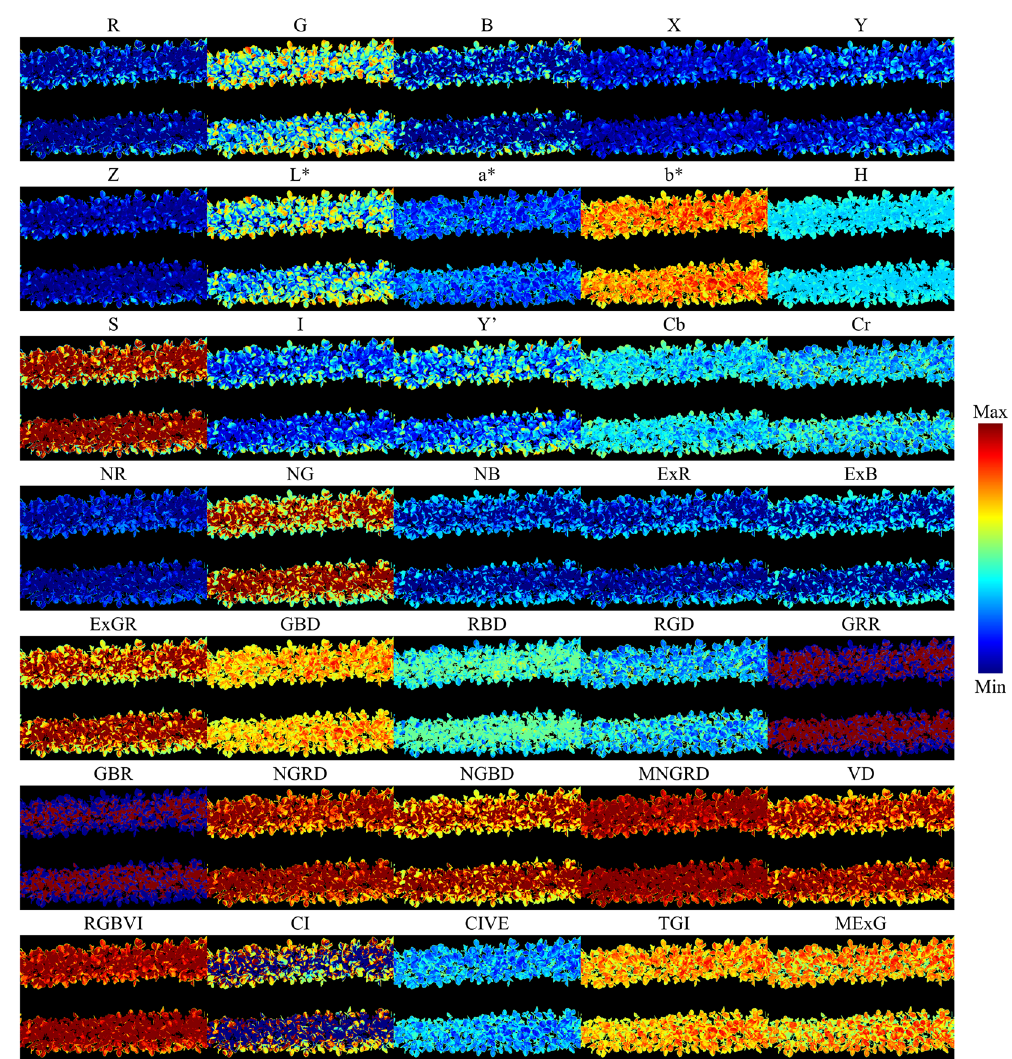
Figure 6. Examples of colorized transformed images containing different color and texture